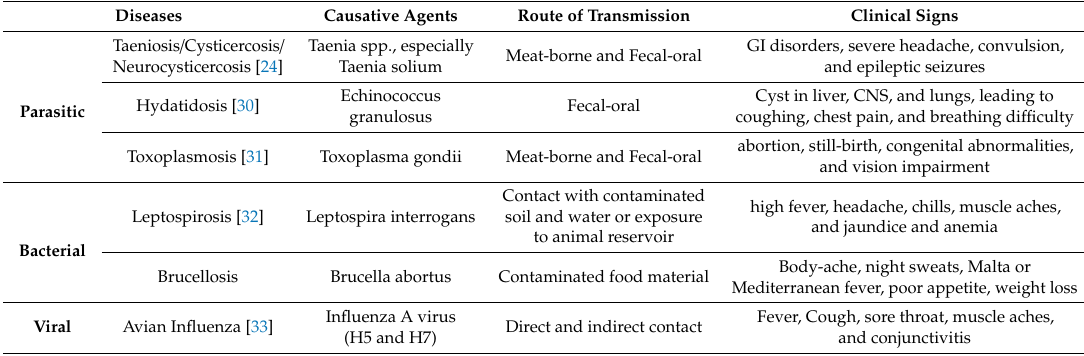
Table 4. Prioritized zoonotic diseases in humans listed by the government of Nepal. GI: gastrointestinal, CNS: central nervous